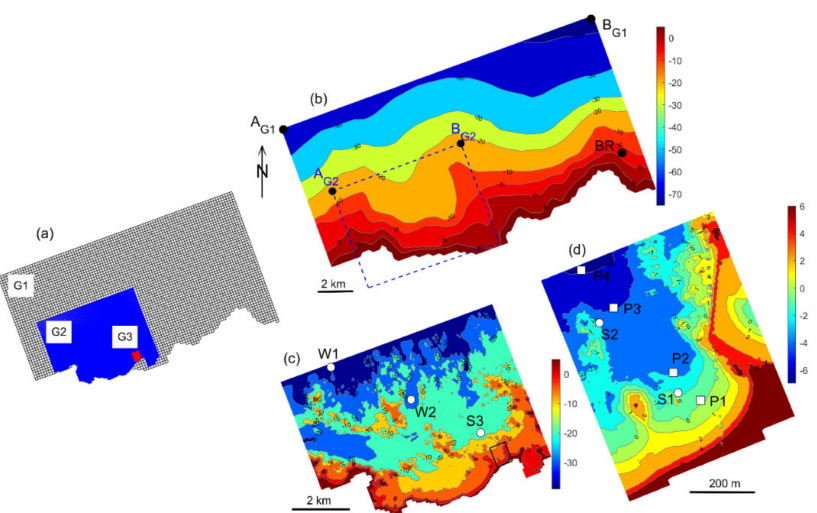
Figure 4. Model setup: ( a ) nested model grids, G1, G2, and G3; ( b ) bathymetry of the large-scale G1 grid, astronomical tides were obtained at A G1 and B G1 from the ES2008 tidal database, BR is the Brignogan wind station, the dashed blue line indicates the extent of the G2 grid, and A G2 and B G2 are the locations where the simulated water levels were extracted for G2. ( c ) Bathymetry of the G2 grid, where W1 and W2 indicate the wave data points from WW3 (HOMERE database), S3 is the offshore pressure sensor, and the black square indicates the extent of the G3 grid. ( d ) Bathymetry of the study area (G3), where S1 and S2 are nearshore pressure sensors and P1 to P4 are the selected locations to analyze the wave